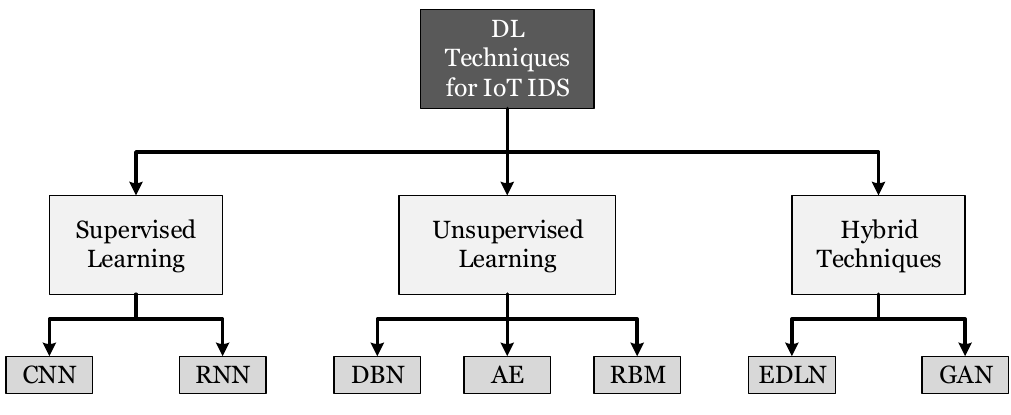
Figure 16. Taxonomy of potential DL techniques for IoT